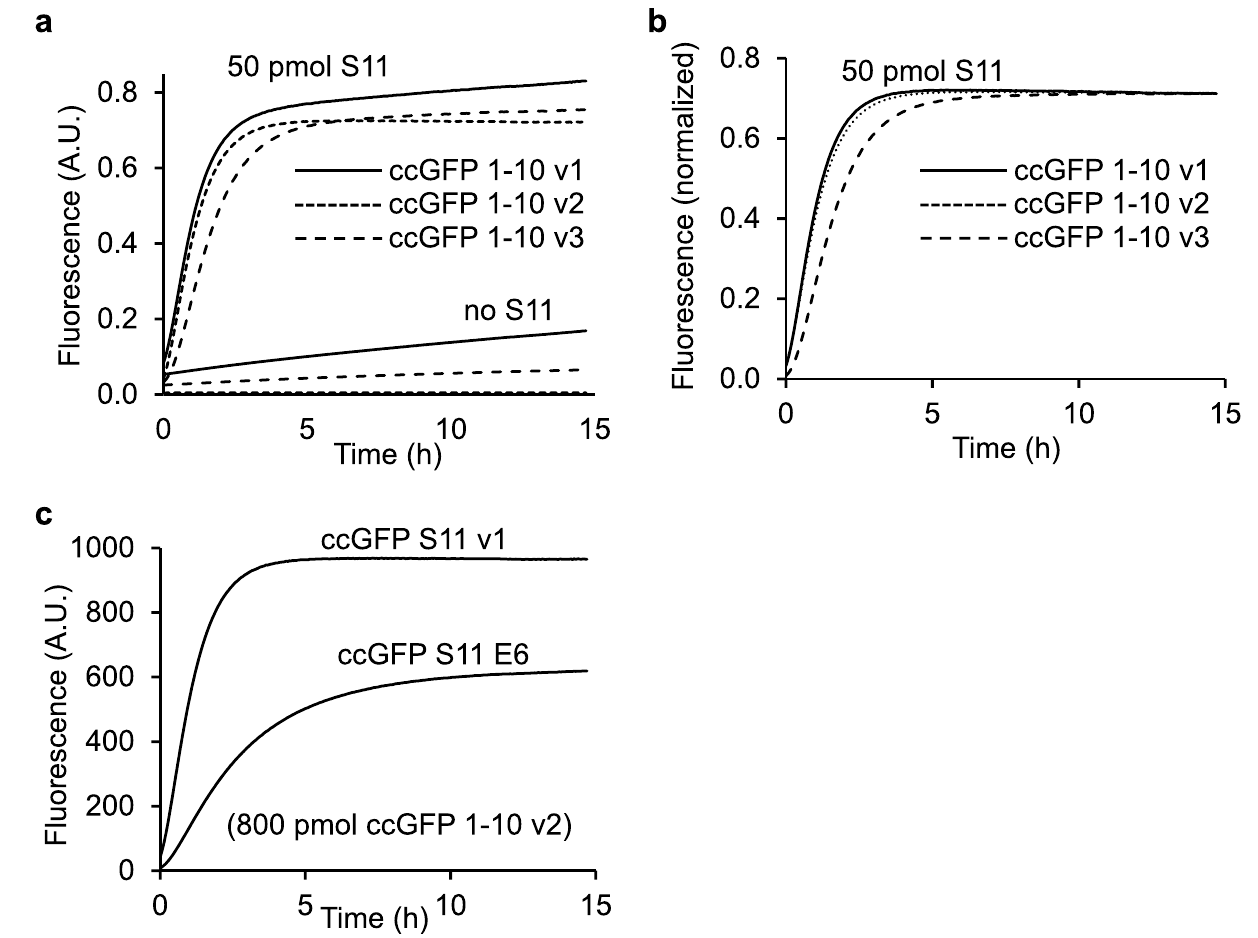
Figure 2. Complementation and autofluorescence of purified ccGFP 1–10 fragments. ( a ) Progress curves for in vitro complementation after mixing indicated ccGFP 1–10 variant (800 pmol) with SR-ccGFP S11 v1 (50 pmol) in 200 µl reaction wells (upper traces); development of autofluorescence of each ccGFP 1–10 without added S11 (‘no S11’, lower traces). Due to lack of chromophore residues, S11 fragments are not autofluorescent as expected (not shown). Maximum arbitrary scale signal (~ 0.8) corresponds to 45,000 fluorescence units on BioTek instrument (99,999 full scale). Progress curves were normalized by dividing measured fluorescence by the fluorescence of sfGFP control to compensate for instrument drift and jitter noise (Supplementary Fig. S8). ( b ) Normalized progress curves for indicated ccGFP 1–10 variant from ( a ) after subtraction of progress curve of corresponding ccGFP 1–10 fragments alone (‘no S11’). ( c ) In vitro complementation of equal molar amounts of ccGFP S11 variants (50 pmol) with ccGFP 1–10 v2 (800 pmol) in 200 µl reaction